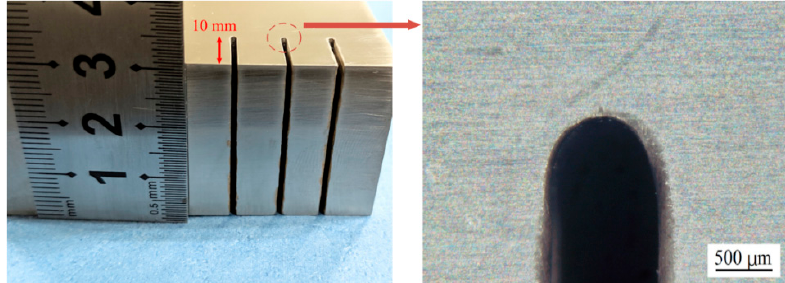
Figure 15. Kerfs machined on a 30-mm-thick block.